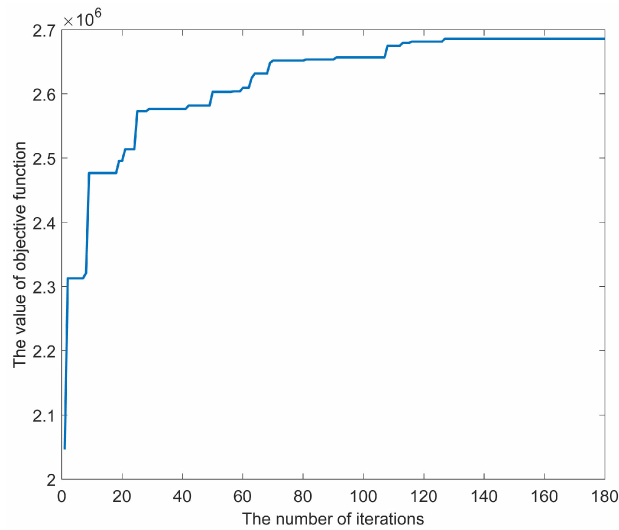
Figure 11. The convergence curve of the real-world case.